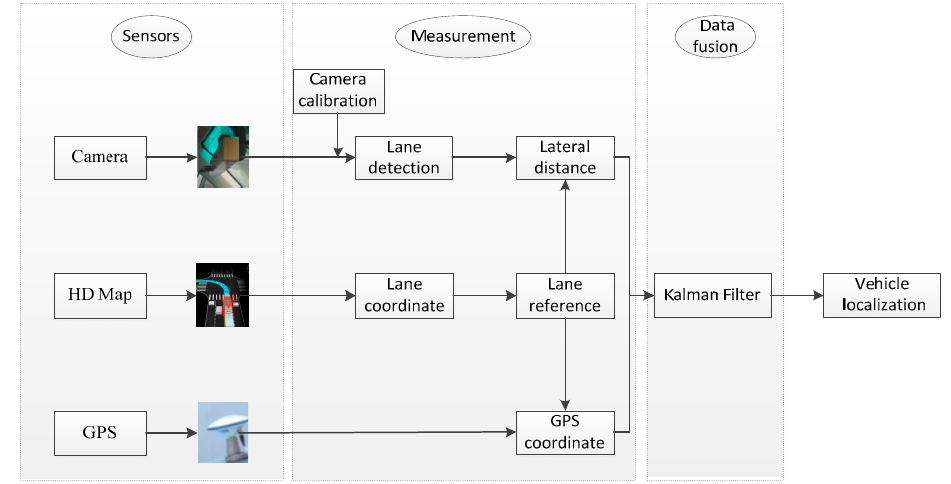
Figure 1. Flowchart of the proposed method.